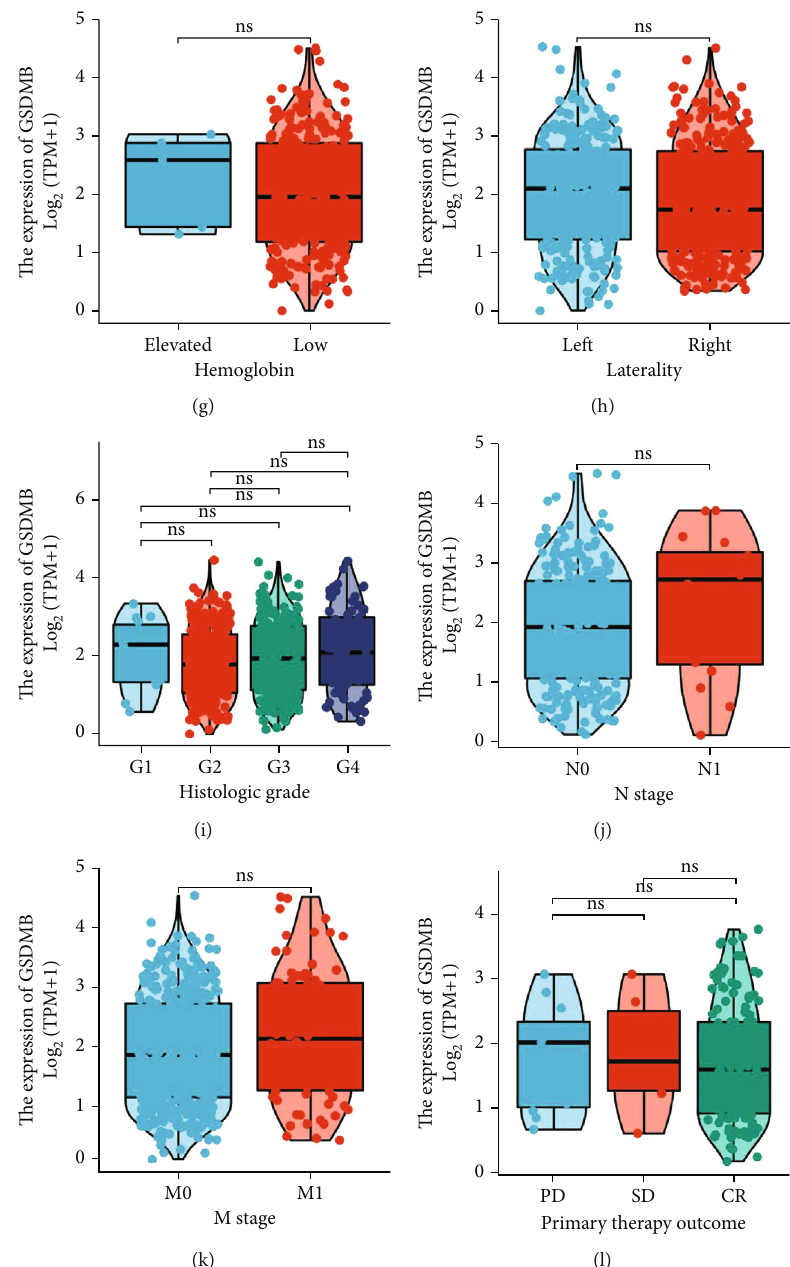
Figure 3: Relationships between GSDMB mRNA levels and clinical pathological characteristics. Higher expression levels of GSDMB were observed in patients with a high T stage (a, c) and patients with a high pathologic stage (b). No statistically signi fi cant correlation was found between the expression levels of GSDMB and gender (d), age (e), serum calcium (f), hemoglobin (g), laterality (right or left) (h), histologic grade (i), N stage (j), M stage (k), or primary therapy outcome (l) (ns: no signi fi cance; ∗ P < 0 : 05 , ∗∗ P < 0 : 01 , and ∗∗∗ P < 0 : 001